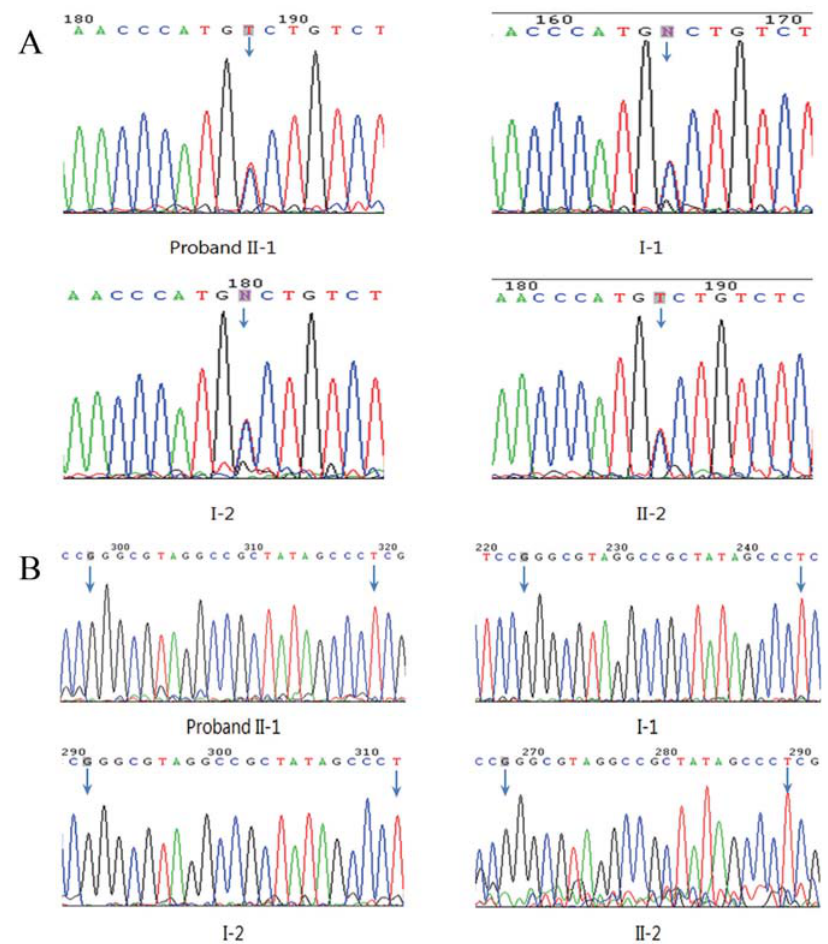
Figure 6- DNA-sequencing chromatograms of exon2 of AXIN2 in the female proband (II-1) and her family members A. c.148C>T (rs2240308) in AXIN2 gene was detected in the heterozygous state in the female proband (II-1), and the same variant was present in her unaffected younger brother (II-2) and her